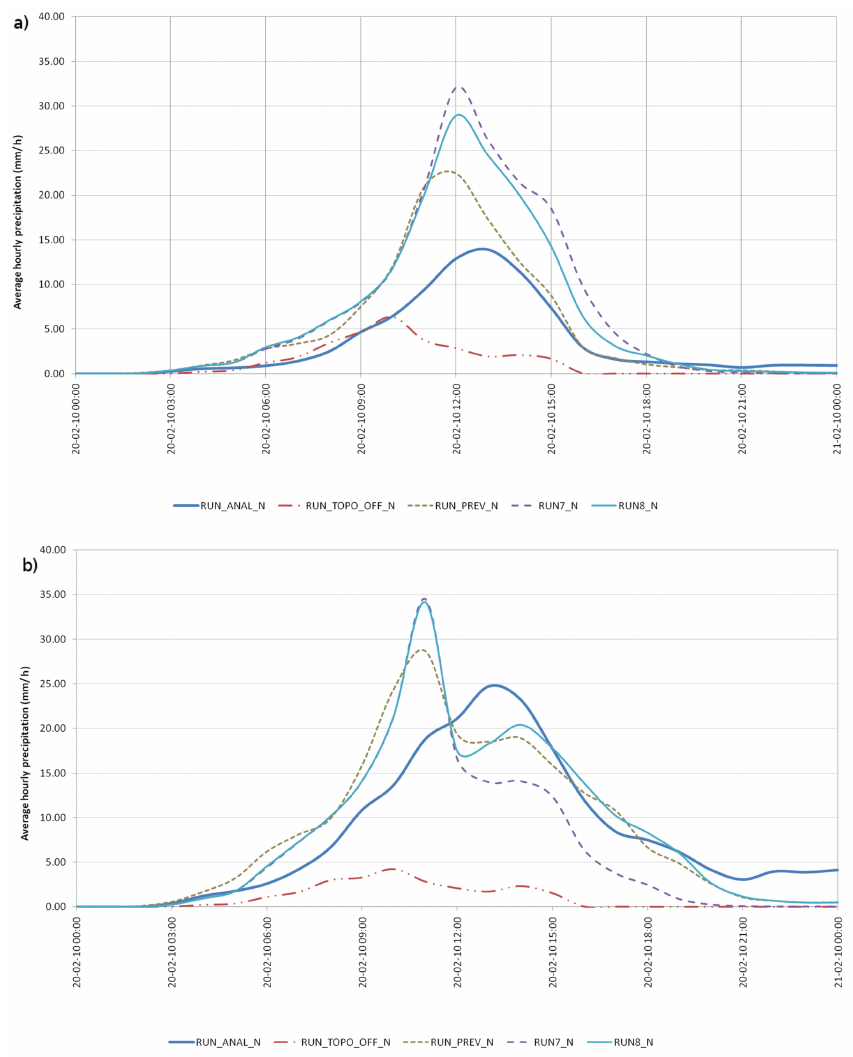
Fig. 8. Time evolution of simulated area-averaged hourly precipitation over the entire ( a ) northern coast and ( b ) southern coast, over domain D2.